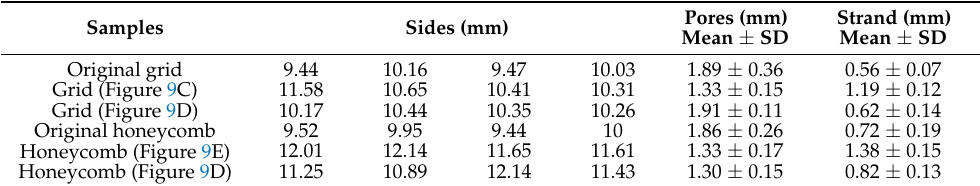
Table 2. Measurements obtained for the scaffolds and original BIOX CAD derived from ImageJ measurements presented Figure 9. Information regarding GEN-Coll/MBG_Sr4%, T1 and T2 (Figure 9C,D, respectively) and GEN-Coll/nanoHA, T3 and T4 (Figure 9E,F, respectively). Samples